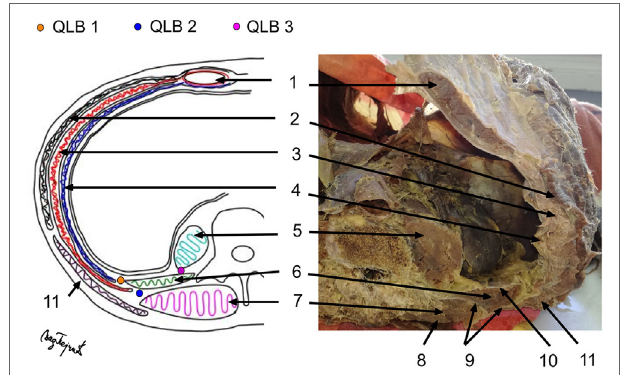
FiGURe 1 | Cross-section of the abdomen—a photo of cadaver and a scheme of anatomical structures. QLB 1—point of local anesthetic (LA) injection for QLB 1; QLB 2—point of LA injection for QLB 2; QLB 3—point of LA injection for QLB 3; 1—rectus abdominis muscle; 2—external oblique muscle; 3—internal oblique muscle; 4 –transversus abdominis muscle; 5— psoas major muscle; 6—quadratus lumborum muscle; 7—erectores spinae muscle; 8—lamina posterior of the thoracolumbar fascia; 9—lamina media of the thoracolumbar fascia; 10—lamina anterior of the thoracolumbar fascia; 11—latissimus dorsi